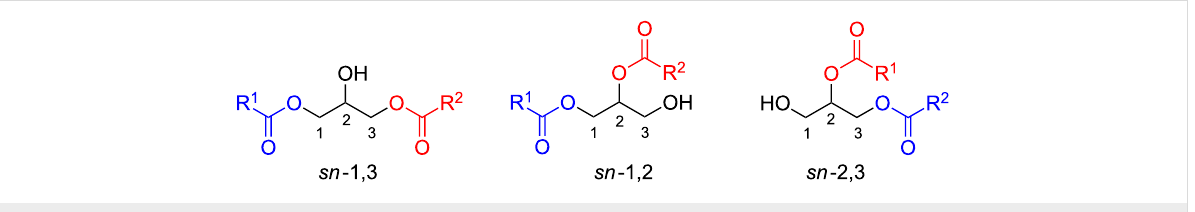
Figure 2: Isomeric diacyl- sn -glycerols